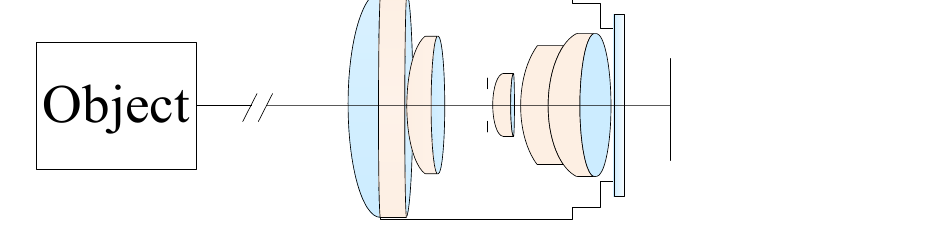
Figure 1. Initial configuration of the miniaturized wide-angle fisheye lens system.